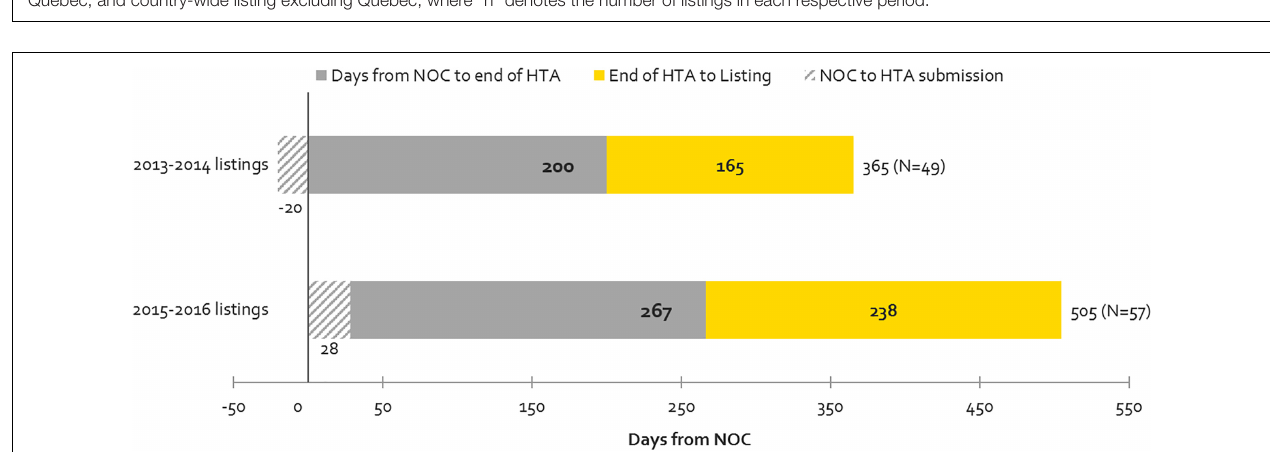
FIGURE 4 | For all CADTH reviewed products, average number of days from NOC to: Quebec listing, first provincial listing in at least one province other than Quebec, and country-wide listing excluding Quebec, where “n” denotes the number of listings in each respective period.